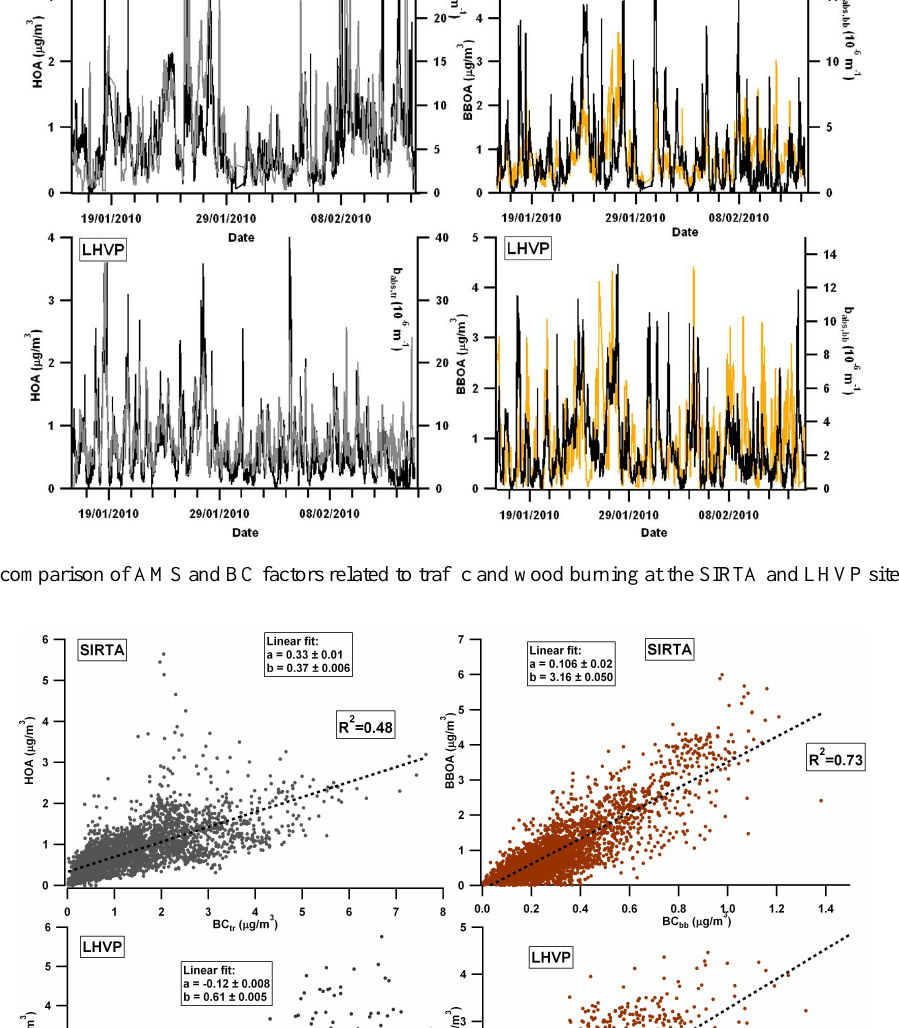
those found from other ambient measurements (Szidat et al.,